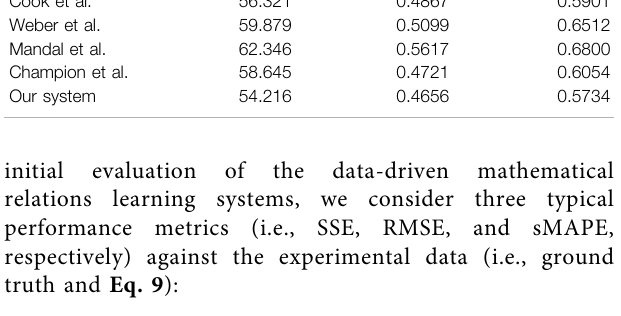
TABLE 4 | Evaluation of the data-driven relation learning systems on tumor growth curve extraction.